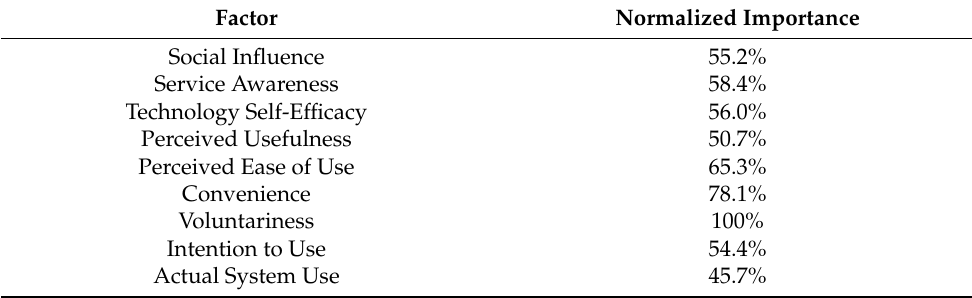
Table 6. Independent variable importance score